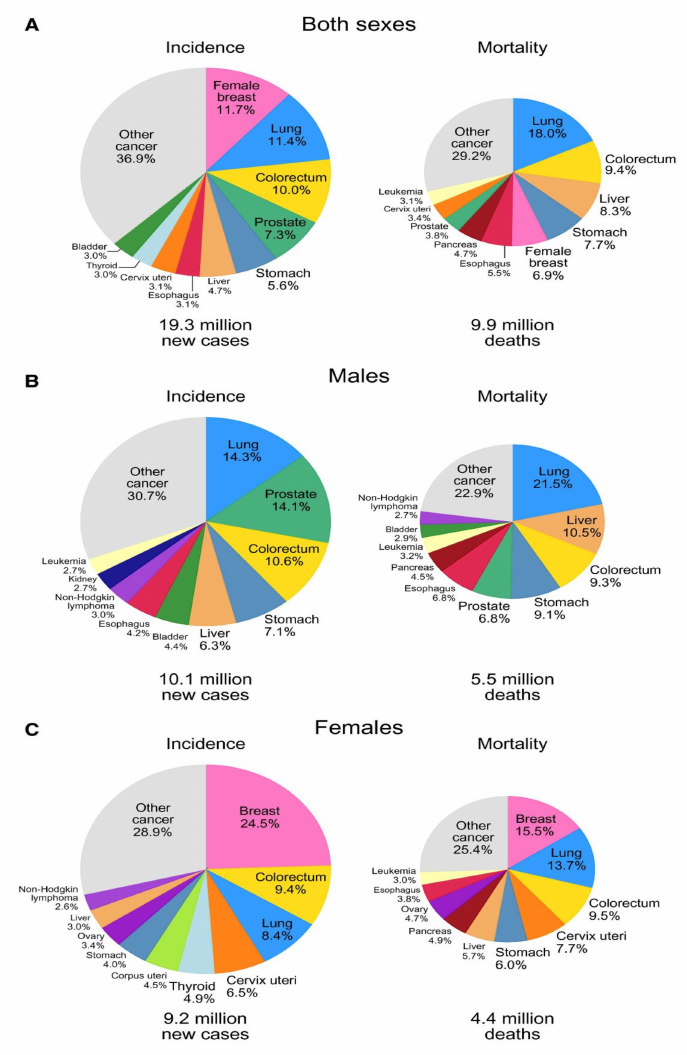
Figure 1. Distribution of cancer incidence and mortality rate for both genders worldwide